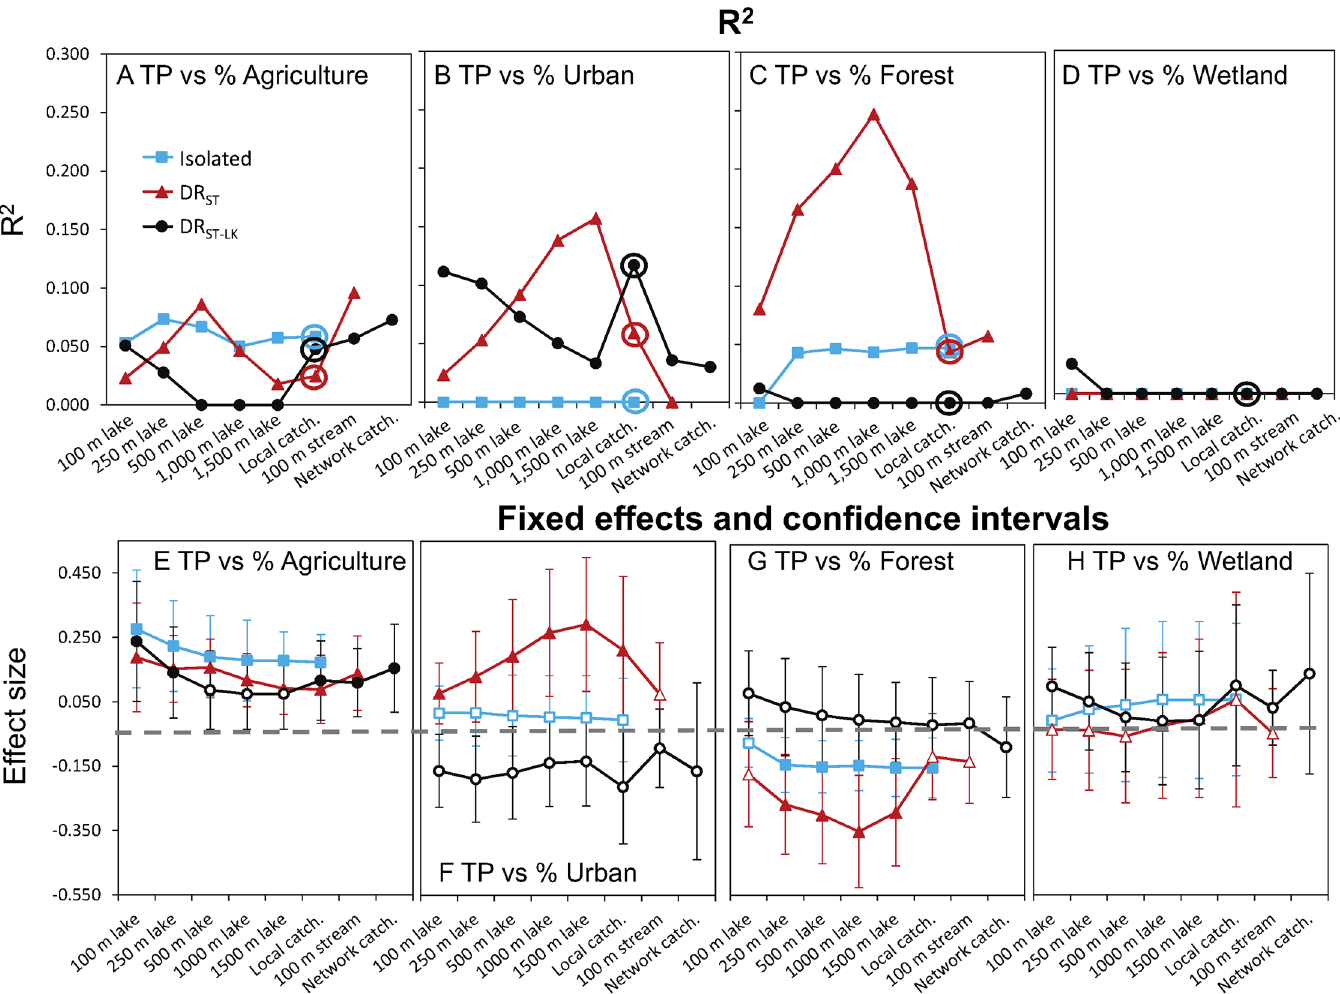
Fig 4. Model fit and effect sizes for the fixed effects in models of land use-lake total phosphorus (TP). For the relationships between TP and individual LULC types by lake class and spatial extent, the R 2 (A-D) and slopes (E-H) from mixed-models with random intercepts and fixed effects of the LULC type. Individual models were fit for each lake class and spatial extent of a particular LULC type combination (i.e., for % agriculture land use, 21 individual models were fit). In plots E-H, the error bars are confidence intervals (CI ’ s) of the slopes from the above models. Filled symbols are for the fixed effect slopes in which the CI does not overlap zero. Note, we show lines connecting the points of each lake class for ease of comparison across lake classes